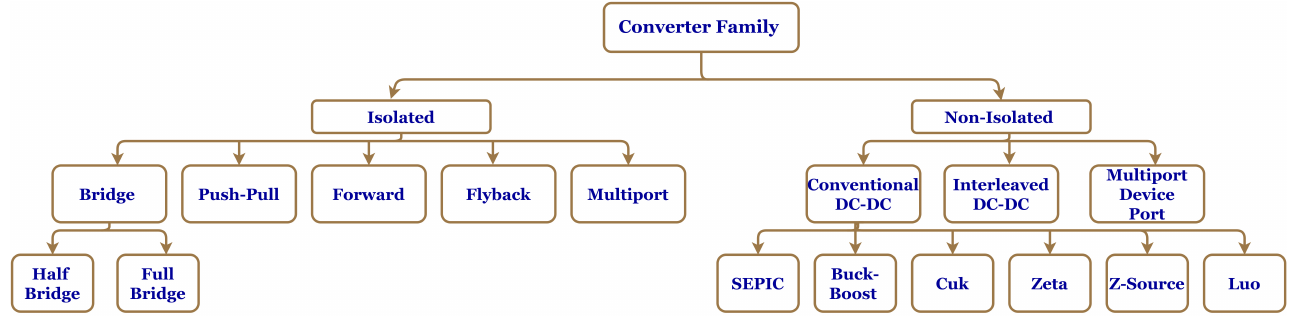
Figure 3. Boostconverter family, including isolated and non-isolated